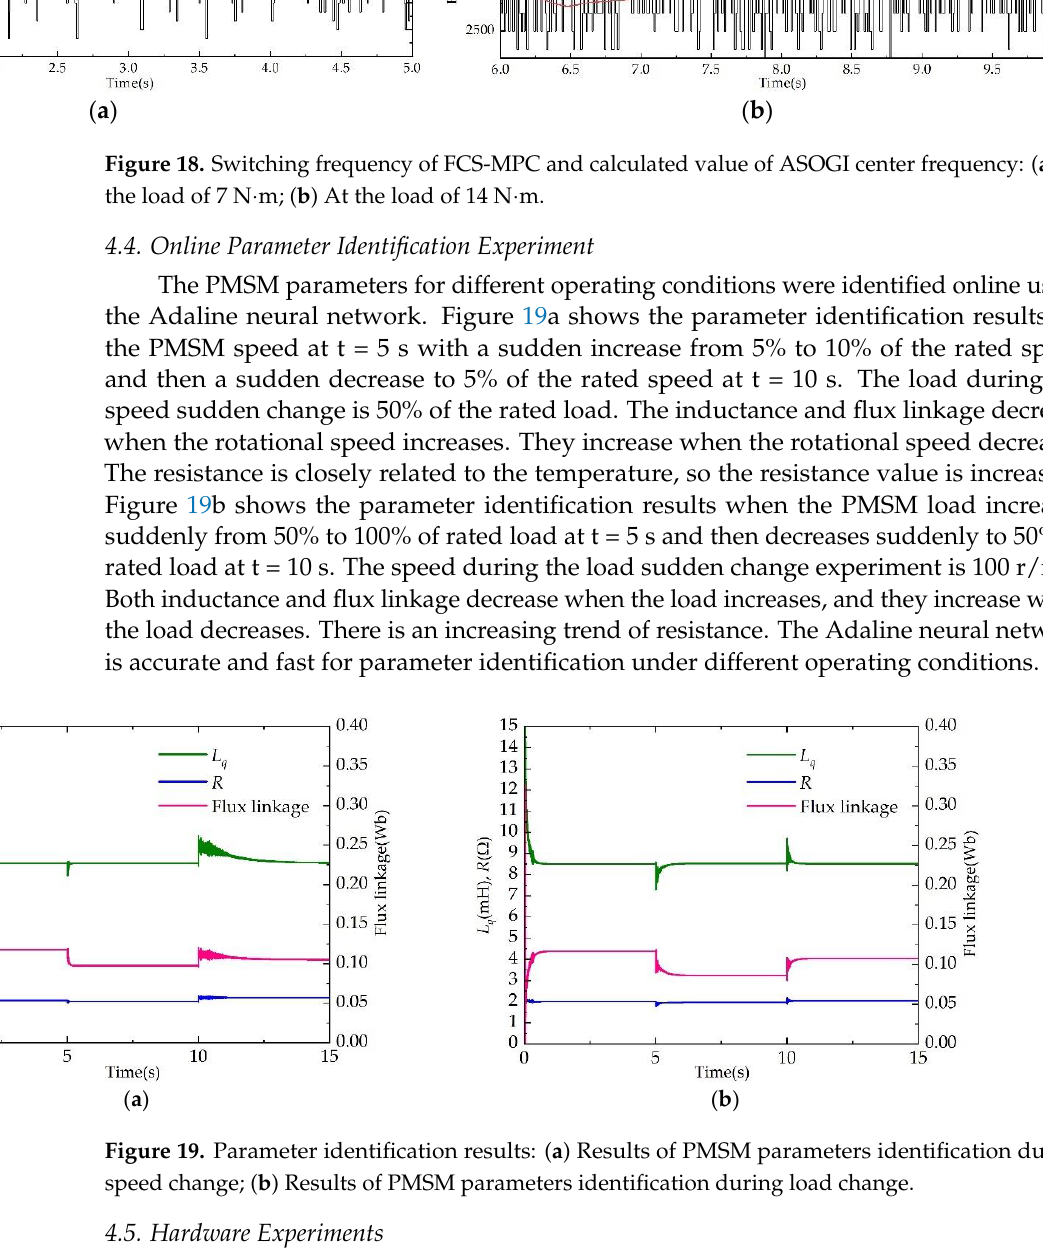
waveform; ( c ) Rotor position local enlarged waveform at t = 5 s; ( d ) Rotor position local enlarged waveform at t = 10 s.